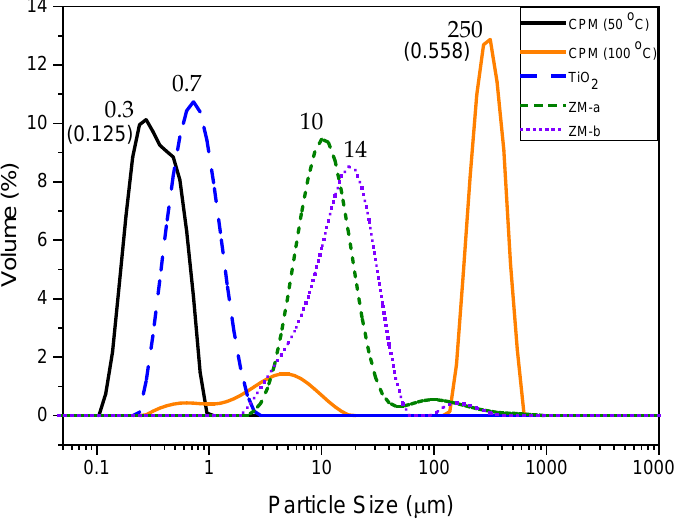
Figure 7. Particle size distributions of caesium phosphomolybdate (CPM) synthesised at 50 °C and 100 °C, titanium dioxide (TiO 2 ) and zirconium molybdate (ZM-a and ZM-b). Corresponding D50 values shown by each relevant peak. Polydispersity index values for CPM at 50 °C and 100 °C shown in brackets.